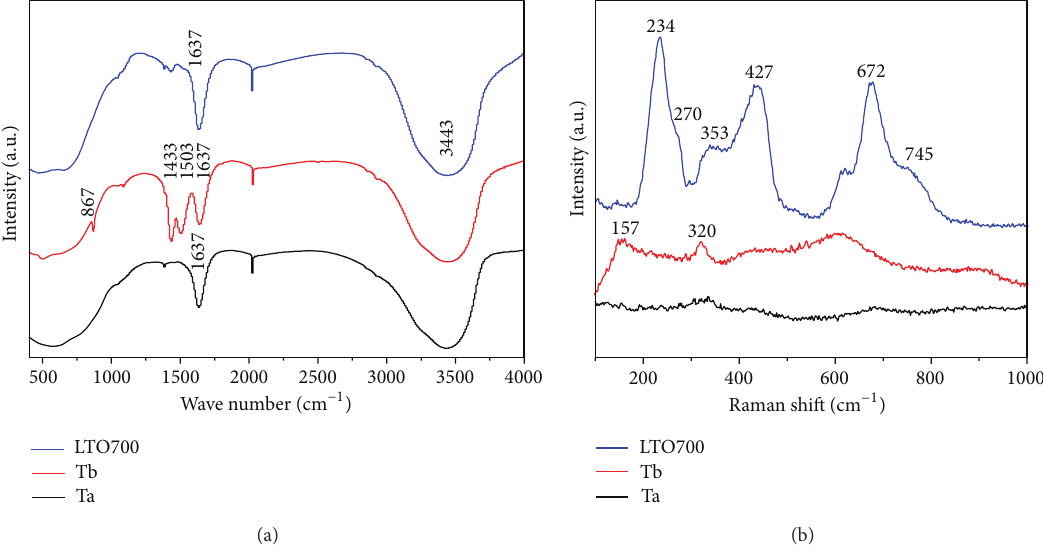
Figure 2: The FT-IR and Raman spectra of samples Ta, Tb and